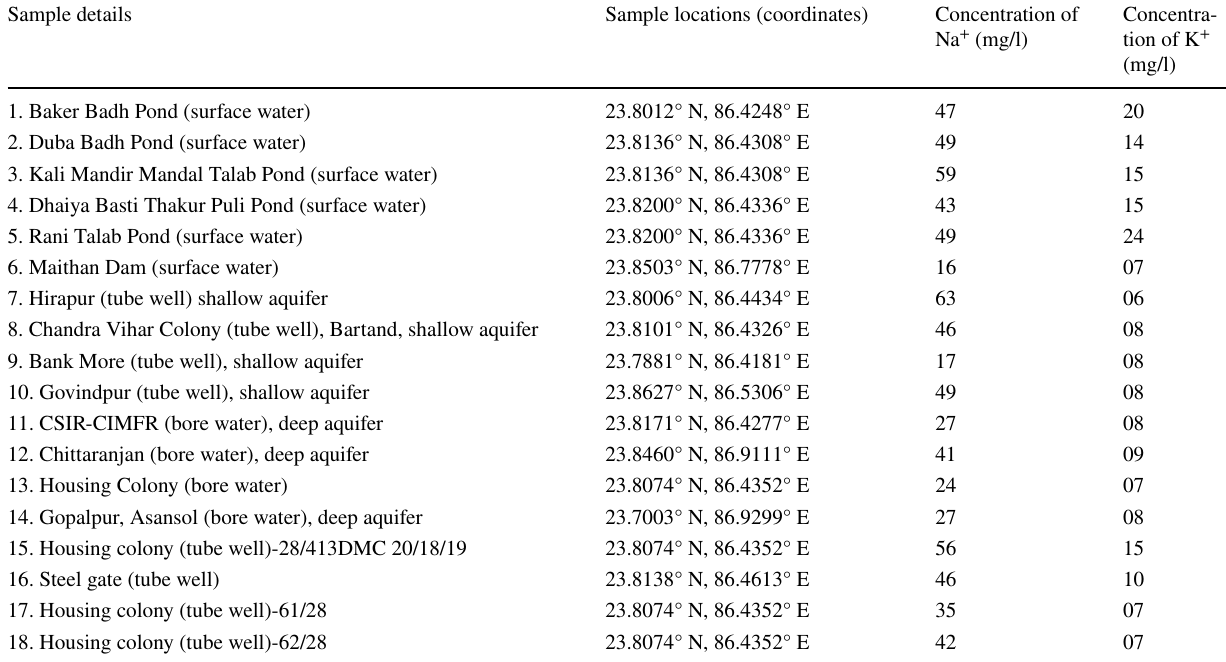
Table 2 Concentration of sodium and potassium ions in the analyzed water samples Sample details Sample locations (coordinates)